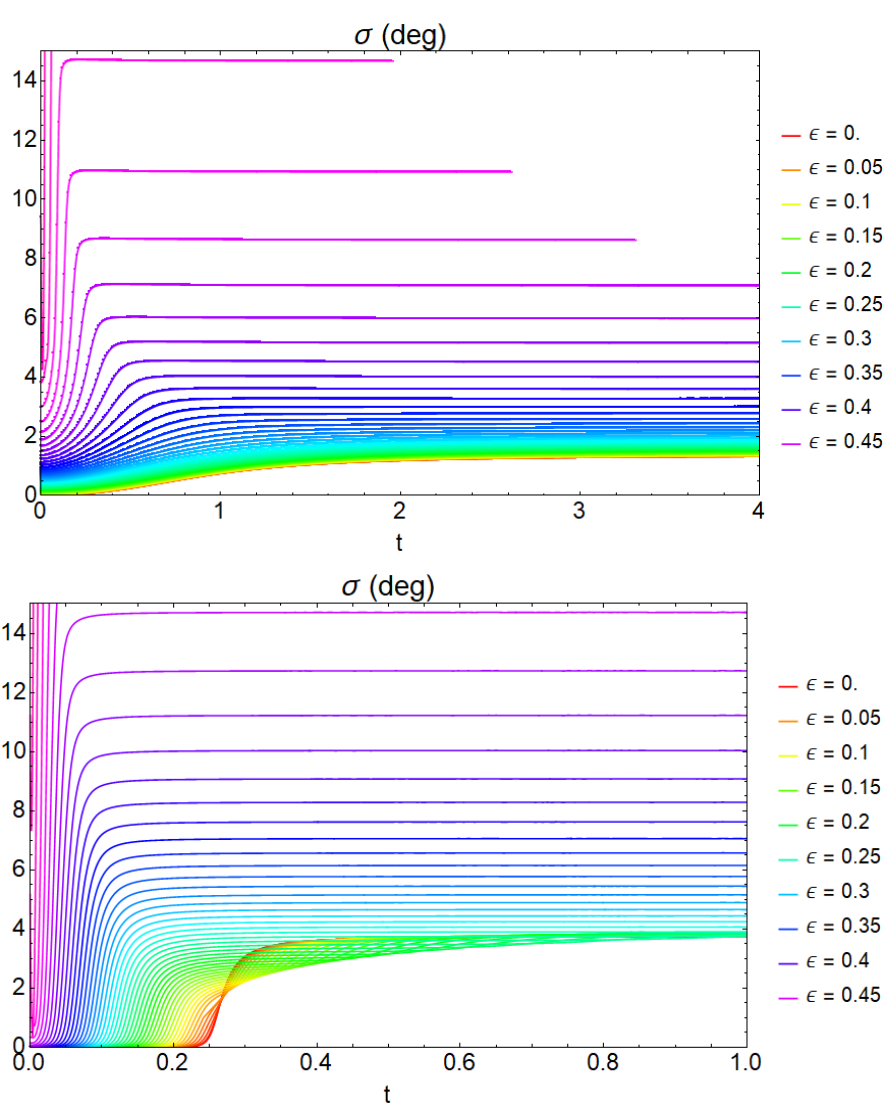
Figure 3 . We depict the time evolution in vacuum of two strings whose endpoints initially move horizontally, with zero downward angle. The upper panel is for the initial condition (2.8) with z 0 = 0 : 02 and the lower panel is for the initial condition (2.9) with z 0 = 0 : 01. Each curve shows the time evolution of the downward angle (cid:27) (not to be confused with the worldsheet coordinate (cid:27) ws ) of the point on the string such that a fraction (cid:15) of the total energy of the string is found between that point and the string endpoint. Hence, (cid:15) = 0 corresponds to the string endpoint and (cid:15) = 0 : 5 corresponds to the string midpoint. The calculation is done entirely in vacuum. And, in the AdS vacuum null geodesics are trajectories with a constant downward angle (cid:27) . We see that each point on the string \nulli(cid:12)es": after some time, each bit of energy along the string moves along a null geodesic with some constant (cid:27) . After nulli(cid:12)cation, the string endpoints move along trajectories with nonzero downward angles.